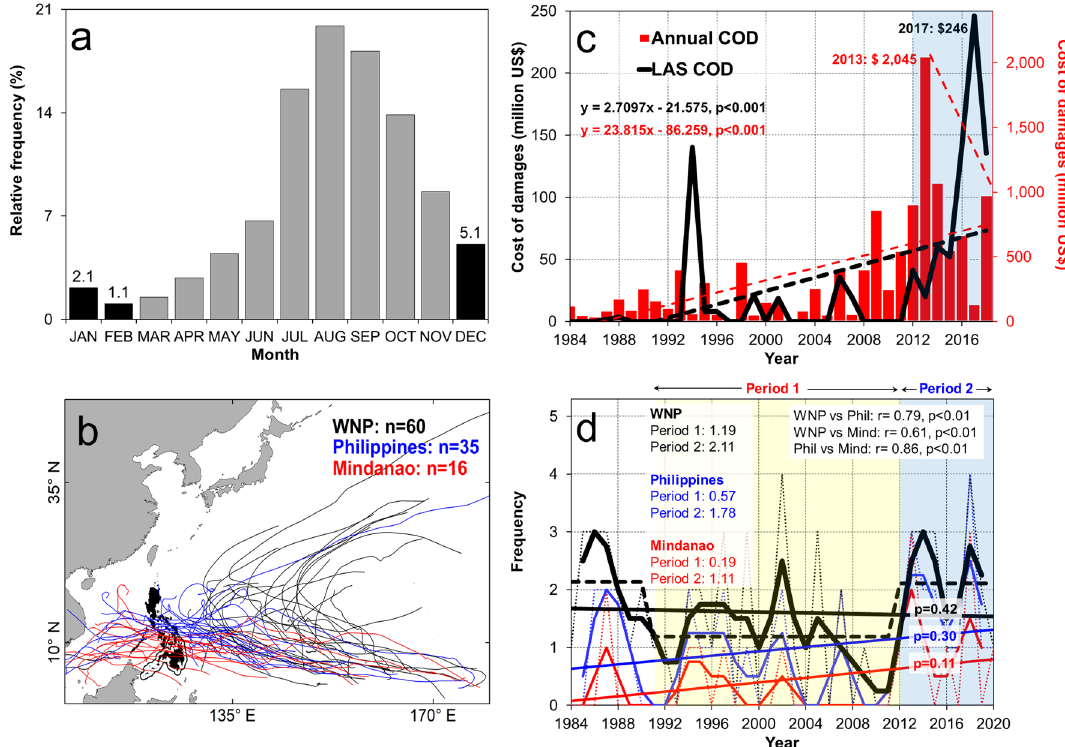
Figure 1. Climatology of Christmas typhoons. ( a ) Monthly tropical cyclone (TC) relative frequency in the Western North Pacific (WNP). The black (gray) bars indicate the less active season (more active season). ( b ) TC tracks during the less active season (LAS) in the WNP (black), in the Philippines (blue), and in Mindanao Island (red). The black shade (line) indicates the location of the Philippines (Mindanao Island). ( c ) Cost of damages (COD) associated with TCs in the Philippines. The red (black) bar (line) indicates the annual (LAS) cost of damages. The significant trend of cost of damages during LAS (black) and in annual terms (red) increased (decreased) in 2012. ( d ) Mean annual Christmas typhoon frequency in the WNP (black), in the Philippines (blue), and in Mindanao (red). The black dashed lines indicate the regime shifts in the WNP during Period 1 (yellow box) and Period 2 (blue box). In ( d ), the inset statistics show the correlation of the timeseries with each other, and the mean TC frequency during Period 1 and Period 2, respectively. The p values of the trends are shown on top of their respective trend lines. In ( b ), the map is plotted using ArcGIS 10.1 (https:// www. esri.